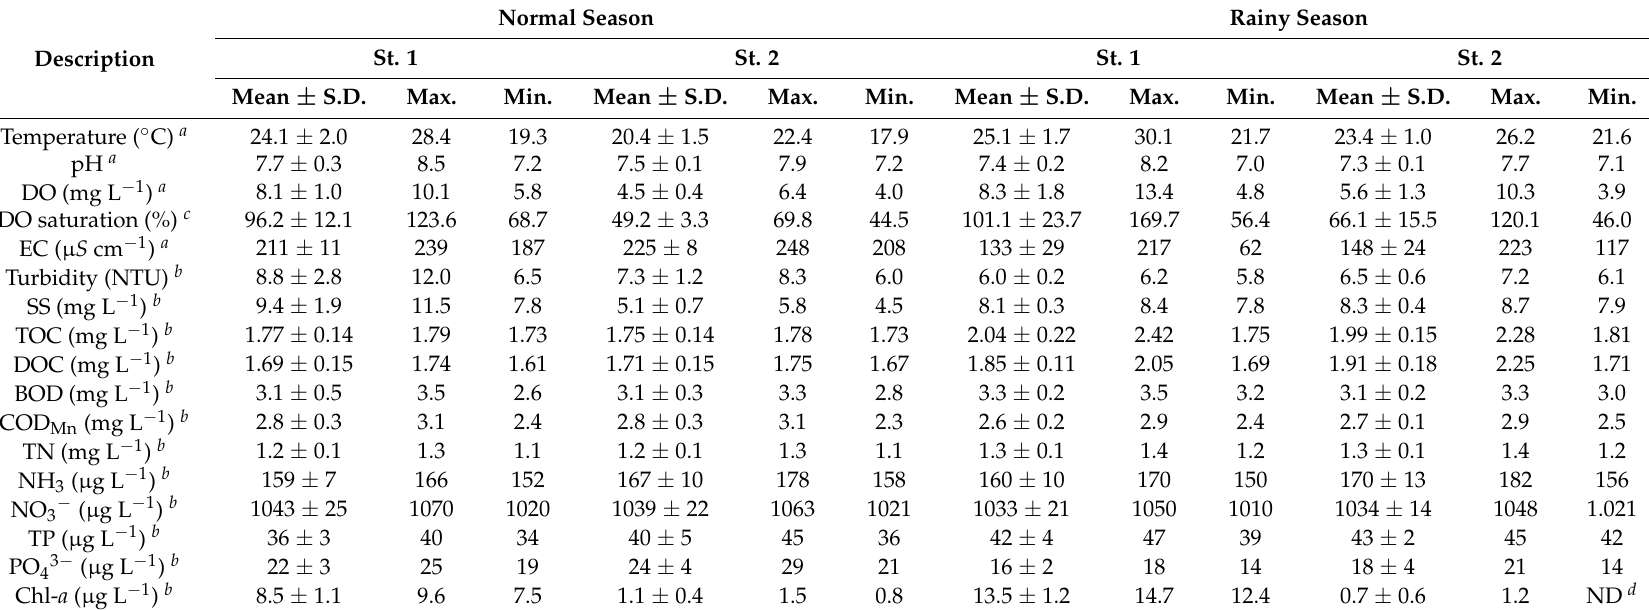
Table 1. Measurement data of the water quality parameters during normal and rainy seasons under stagnant conditions (2012). Normal Season Rainy Season St. 1 St. Description